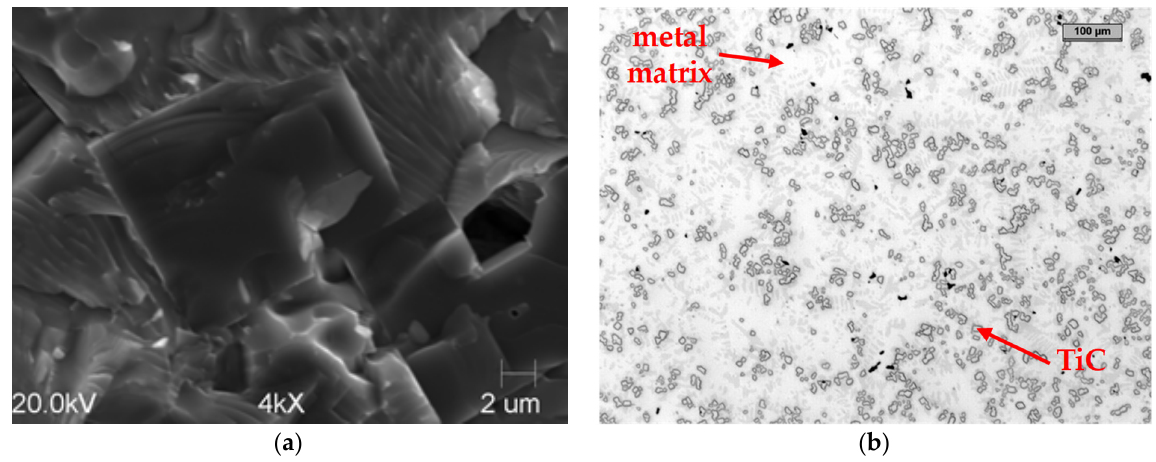
Figure 5. Precipitates of titanium carbides in SEM microstructure ( a ) and microstructure (LM) of high-aluminum cast iron with precipitates of titanium carbides ( b ).